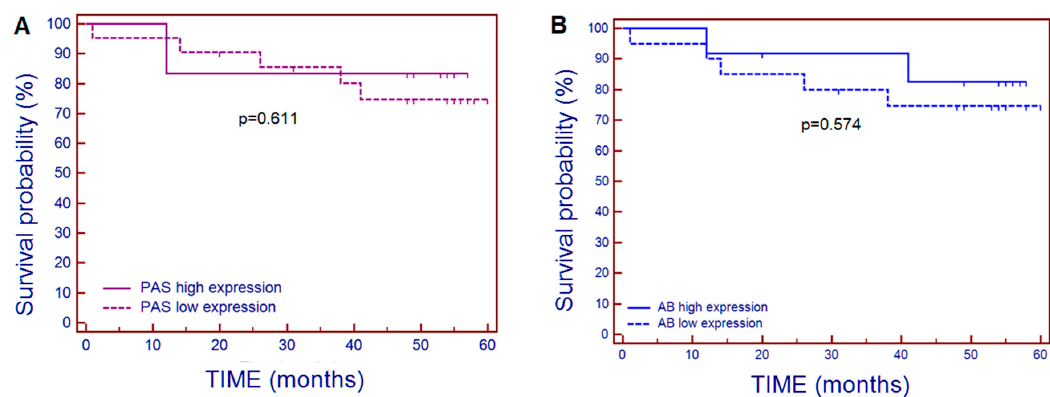
Figure 5. Kaplan-Meier survival curves for CRC patients related to tissue HC reactivity of PAS+ polysaccharides ( A ) and AB+ polysaccharides ( B ), showing that expression of both polysaccharide’s mucins in colorectal carcinoma tissue samples is not associated with survival time. High expression—above-mean tissue expression; low expression—below-mean tissue expression.